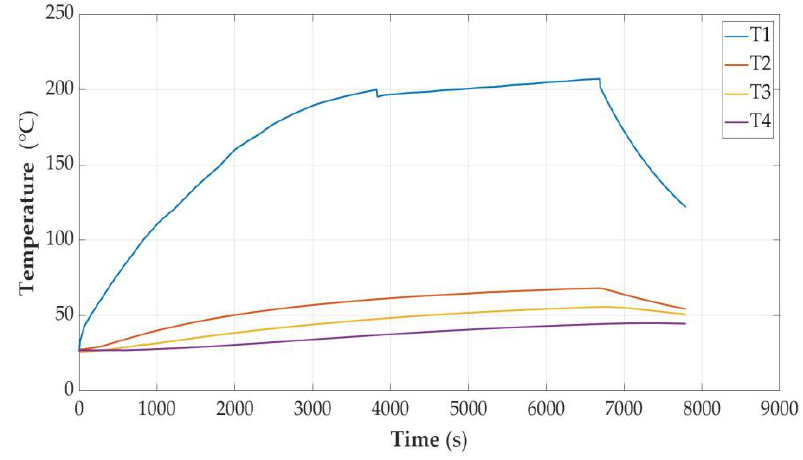
Figure 5. Graphs of temperature changes as a function of time t (s) during heating.